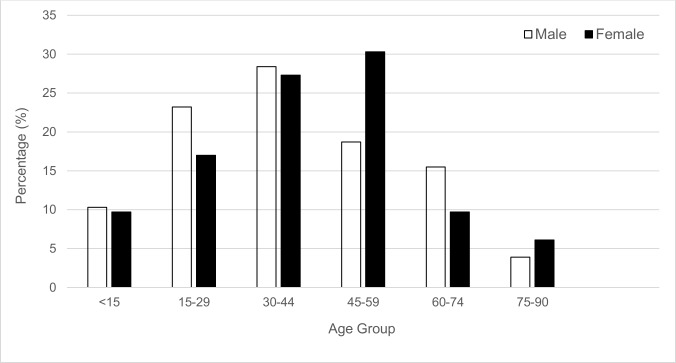
Mortality distribution across different age groups (of 15-year intervals) by gender.